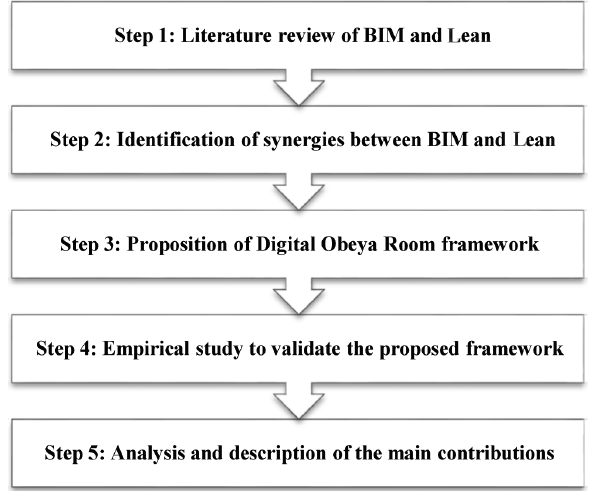
Fig. 1. Methodological research